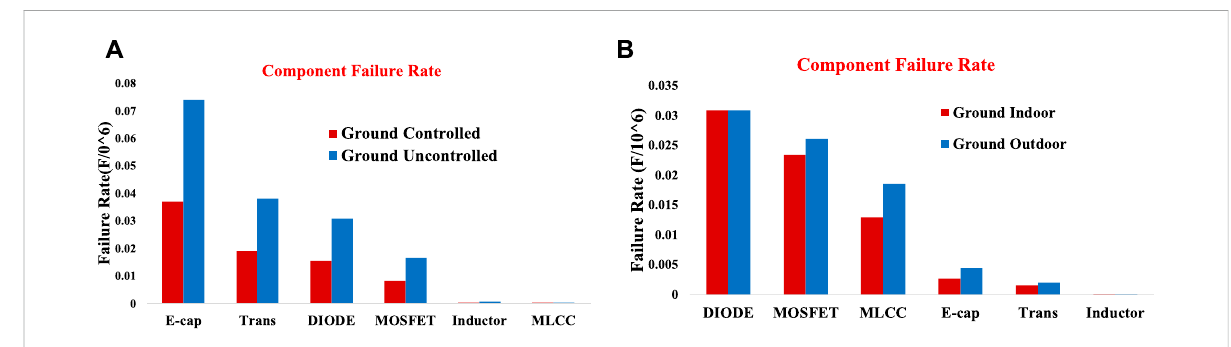
FIGURE 11 The component failure rate in different environments. (A) Telcordia SR-332, (B) 217Plus.